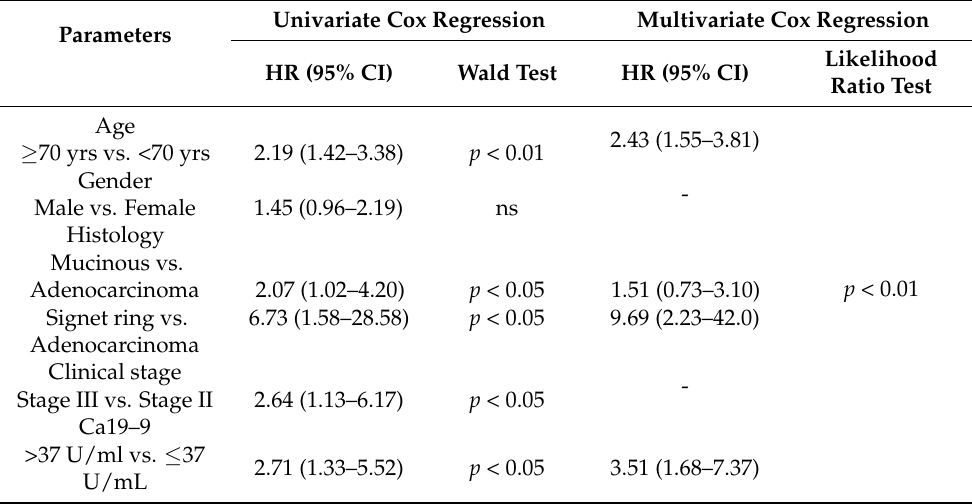
Table 3. Univariate and multivariate analyses of prognostic factors for post-recurrence survival.